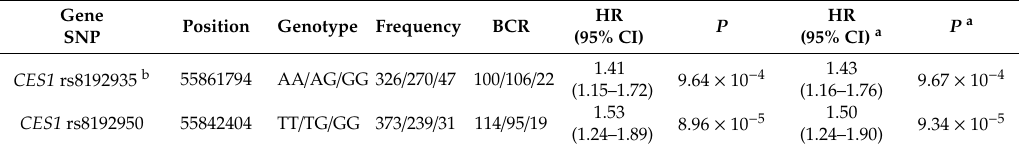
Table 2. SNPs associated with BCR in prostate cancer patients receiving RP.